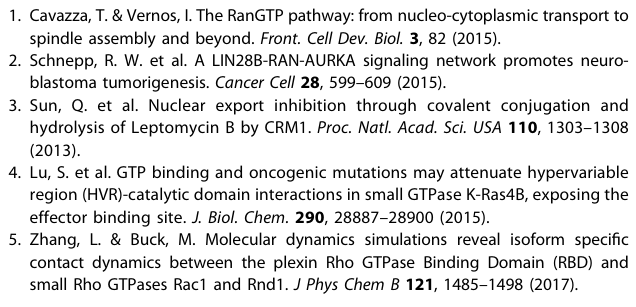
Fig. 1 Design and characterization of GTP-bound full-length Ran via the disruption of the autoinhibitory C-terminal tail. a An illustration of the mutation sites. The Ran (3GJ0) tail is displayed as a cyan cartoon. The G-domain is covered in a partially transparent magenta surface. Four loci of mutagenesis (L182, M189, Y197, and A133) are shown as green sticks or surface. None of these residues is in direct contact with GTP (green sticks) or Mg 2 + (green sphere). b Multiple sequence alignment of Ran from distant species, with the consensus displayed at the bottom. Mutated residues (A133, L182, M189, Y197) are indicated with an * above the alignment. c Stability of different Ran proteins. Ran proteins (1 µM) were incubated at 37 °C for different lengths of time in a buffer containing 20 mM Tris pH 7.5, 300 mM NaCl, 10% glycerol, 5 mM MgCl 2 , 2 mM DTT, 0.001% Triton-X 100, and 50 µM GTP. After thorough spin, the supernatants were analysed by SDS-PAGE. These mutations are not cancer-derived. d Q anion-exchange analysis of bound nucleotide in the puri fi ed Ran proteins. GDP and GTP were eluted as the fi rst and second peaks, respectively. A260, A280, and conductivity are shown as red, blue, and brown lines, respectively. Y197A is less GTP- bound as compared with the other three designed mutants. This is likely due to its higher fl exibility (B-factors) and weak G-domain binding energy contribution. e Bound nucleotide status of L182A and Q69L/L182A at 4 °C in a buffer containing 20 mM Tris pH 8.0, 100 mM NaCl, 5 mM MgCl 2 , and 5 mM β -mercaptoethanol. f GST-tagged yeast ( Saccharomyces cerevisiae ) RanBP1 (GST-yRanBP1) pull-down of different concentrations of Ran WT , Ran Q69L , and Ran L182A . Ran L182A consistently appears larger than the rest of Ran mutants in SDS-PAGE, although the sequence has been veri fi ed by DNA sequencing. g GST-yRanBP1 pull-down of Ran and different mutants at 1 µM concentration. Ran 1-179 is not supposed to bind RanBP1 even if it is GTP-bound. The same batch of freshly puri fi ed Ran proteins was used here. h GST-Imp α 1 (71-529) pull- down to show that the binding to RanBP1 is speci fi c. Since Ran and GST are similar in size on SDS-PAGE, GST-Imp α 1 rather than GST was used in this pull-down. i GST-NES pull-down of yCRM1. L182A puri fi ed in the presence of 1 mM GTP is denoted as L182A*. There is no signi fi cant CRM1 binding difference for RanL182A puri fi ed in the presence or absence of GTP. j Superimposition of three Ran-RanBP1-CRM1 crystal structures obtained in this study. CRM1 is shown in magenta, RanBP1 is shown in cyan, and Ran is shown in yellow (L182A), grey (M189D) and salmon (Y197A). Mutated residues are shown as spheres. CRM1 was used to help the crystallization process, but was omitted for clarity in the subsequent panels since it is distant from the mutation sites. k Crystal structure of Ran L812A (yellow) in complex with yRanBP1 (cyan). The mutated residue L182 (sphere) does not interact with RanBP1. l Superimposition of Ran L182A -RanBP1 with Ran Y197A -RanBP1. m Superimposition of Ran L182A -RanBP1 with Ran M189D -RanBP1. To improve clarity, this panel is shown in ribbon representation. n Zoom-in view of the boxed region in ‘ panel- m ’ , with RanBP1 displayed in the electrostatic surface potential map. Residues 189 and 191 are shown in stick representation. o 2F o -F c omit maps (blue mesh) of Ran C-tail contoured at 1 σ level. Ran is shown as cartoon and stick representation. The electron density of Ran M189D is improved in the circled region. The buried surface area (BSA) between Ran C-terminal residues (177-216) and RanBP1 was calculated by PISA in CCP4 and is displayed in the fi gure. The buried surface area for Ran WT is 1591Å